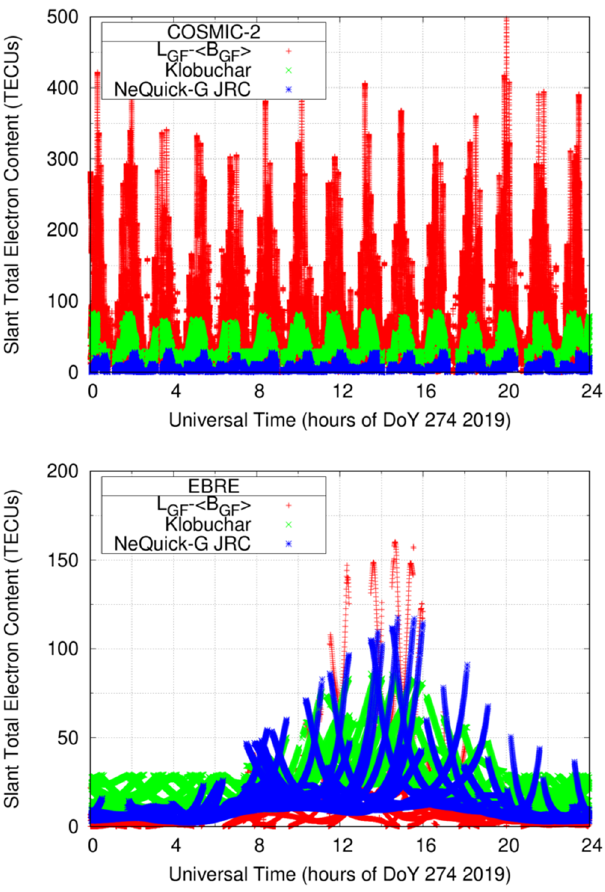
Figure 4. STECs computed for receiver on-board a COSMIC-2 satellite ( top ) and for the permanent ground receiver EBRE ( bottom ), using the Klobuchar model (green), the NeQuick-G model (blue), and the reference STECs (red) obtained by the CCL procedure.